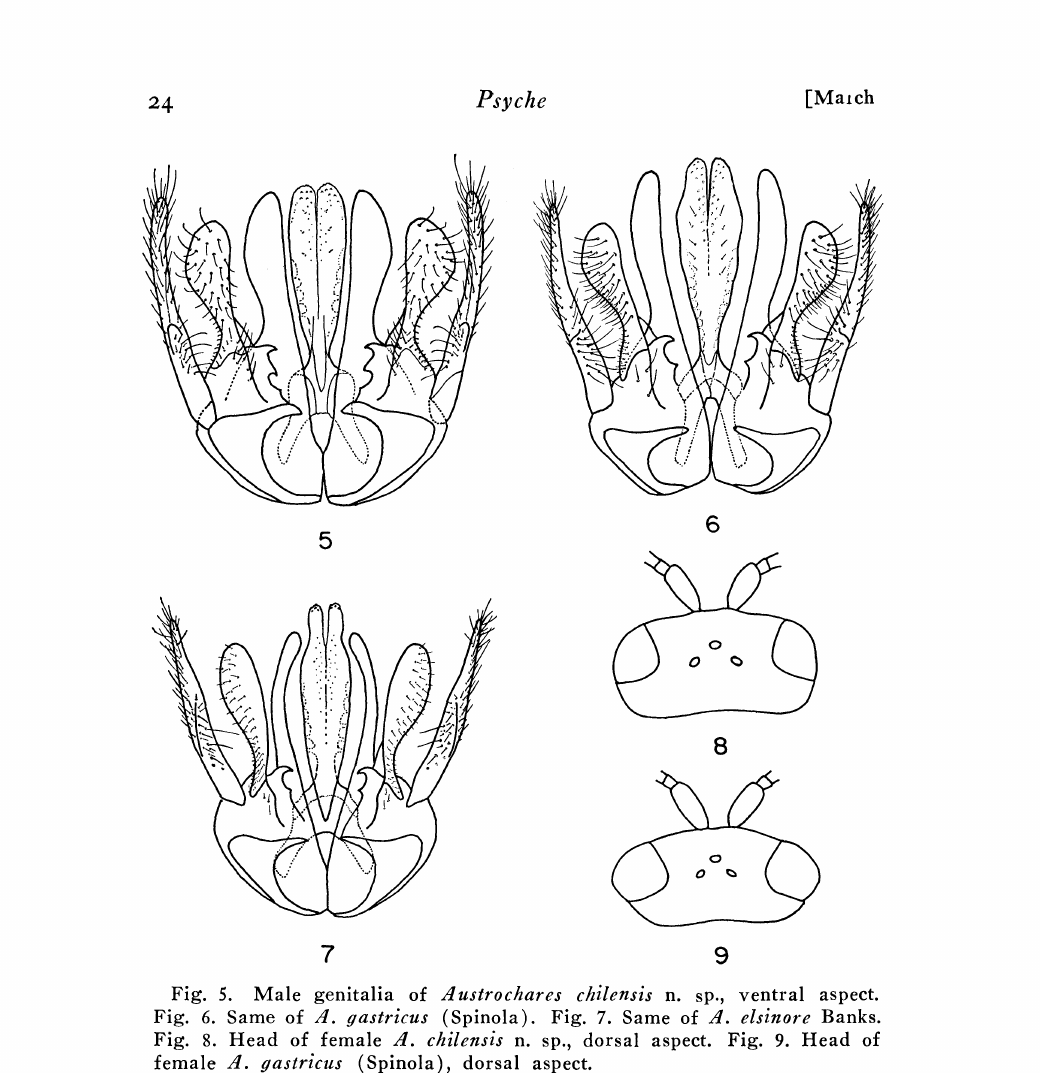
Fig. 5. Male genitalia of 2/ustrochares chilensis n. sp., ventral aspeet. Fig. 6. Same of 2/. gastricus (Spinola). Fig. 7. Same of 2/. elsinore Banks. Fig. 8. Head of female 2/. chilensis n. sp., dorsal aspect. Fig. 9. Head of female 2/. gastricus (Spinola), dorsal aspect. Head, thorax, legs, and antennae black, abdomen wholly ferruginous; ore wing wings lightly inuscated except more clouded on apical two-thirds and especially in a band along outer margin; pubescence o head and thorax dark, somewhat violaceous; propodeum with numerous rather long setae. Clypeus :.5 X as wide as high; middle interocular distance .63 X transacial distance; upper interocular distance .8o X lower interocular, vertex arched above eye tops; postocellar and ocello-ocular lines subequal; head thick behind